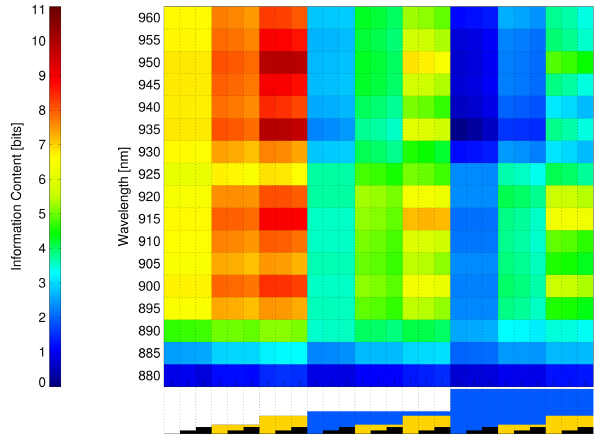
Fig. 8. Information content concerning water vapour of a retrieval using two window channels (METimage: 865, 1020 nm) and one absorption channel (width 10nm, nadir view) for 27 cases of differ- ent atmospheric circumstances (abscissa with legend equivalent to Figure 5).